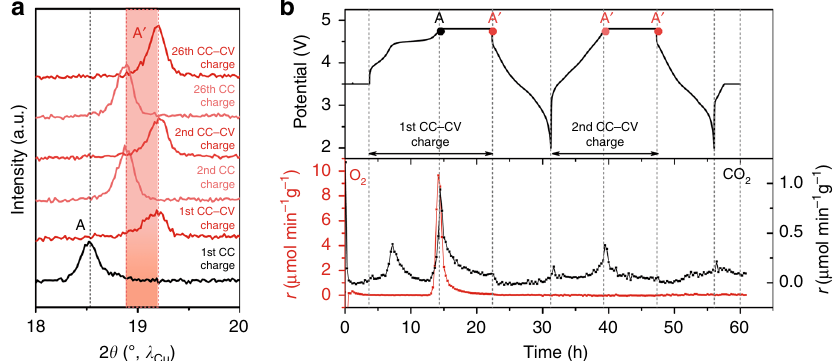
Fig. 3 Operando XRD and OEMS studies of Li-rich NMC during the fi rst cycle and subsequent cycling. a Laboratory XRD patterns of Li-rich NMC collected at various state of charge in an operando XRD cell, which was cycled between 4.8 and 2.0 V, with an intermediate CV step at 4.8 V for 5 h at each cycle. b OEMS gas analysis during the fi rst and second cycles of Li-rich NMC. The cell has been cycled at C/10 between 4.8 and 2.0 V, with a CV step at 4.8 V for 8 h. O 2 ( m / z = 32) and CO 2 ( m / z = 44) ion currents were recorded and then converted to gas evolution rates. The potential versus time curves is presented in the upper panel, and the evolved rates of O 2 (red line) and CO 2 (black line) in the units of μ mol min − 1 g − 1 are shown in the bottom